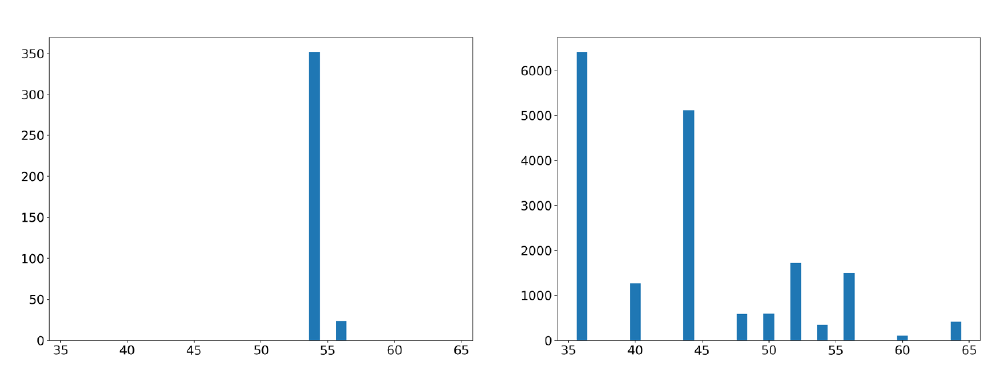
Figure 6 . The histograms of c 2 ; 3 for the 3-generation island in the left panel and all region in the right panel. The axes are the same as (cid:12)gure 4.